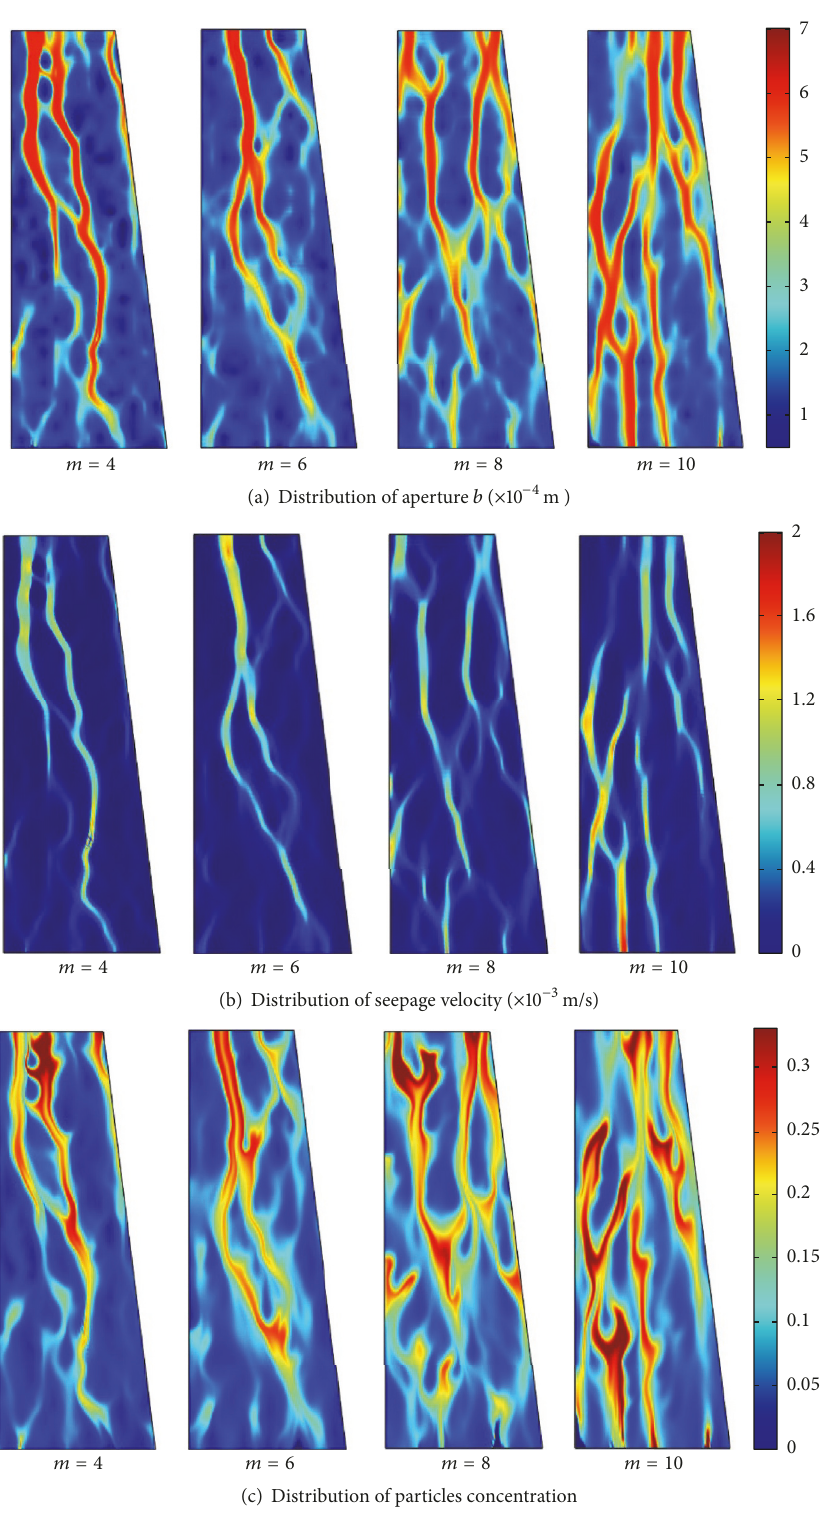
Figure 23: Distribution of fracture, seepage velocity, and particle concentration at different Weibull distribution conditions. (a) Impact of Weibull distribution on fractures evolution; (b) impact of Weibull distribution on water velocity evolution; (c) impact of Weibull distribution on particle concentration